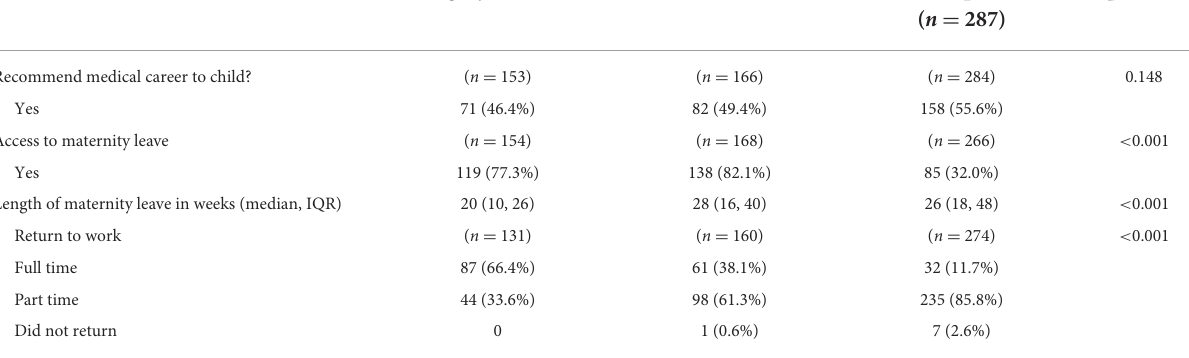
TABLE 3 Factors associated with pregnancy